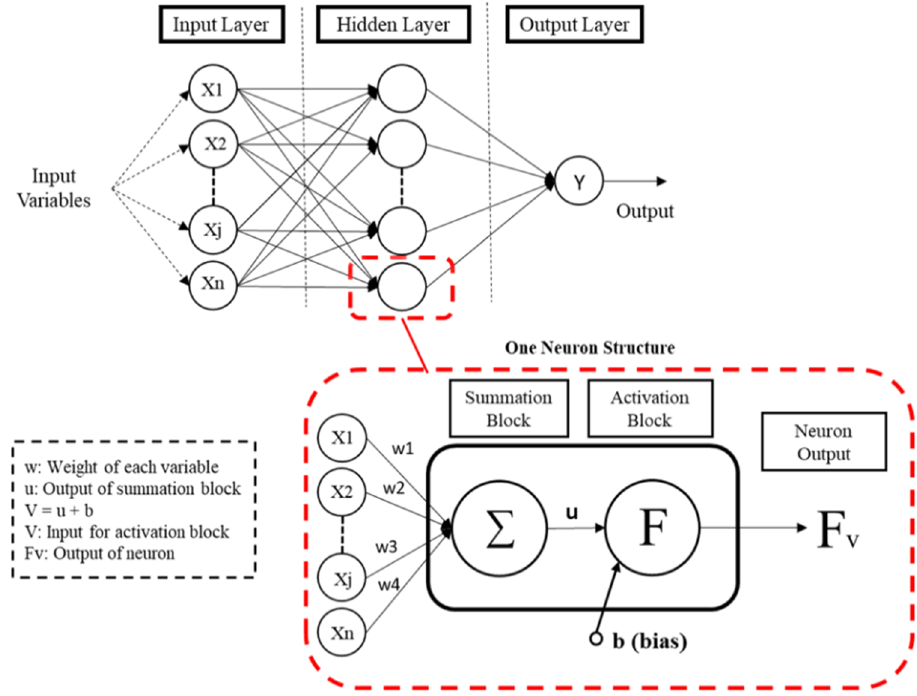
Figure 1. Summary of the artificial neural network structure.